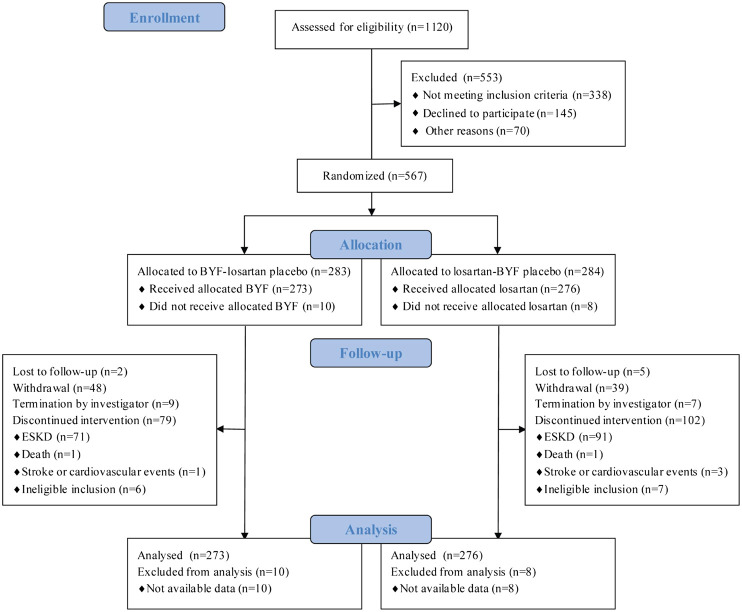
Participant flowchart.